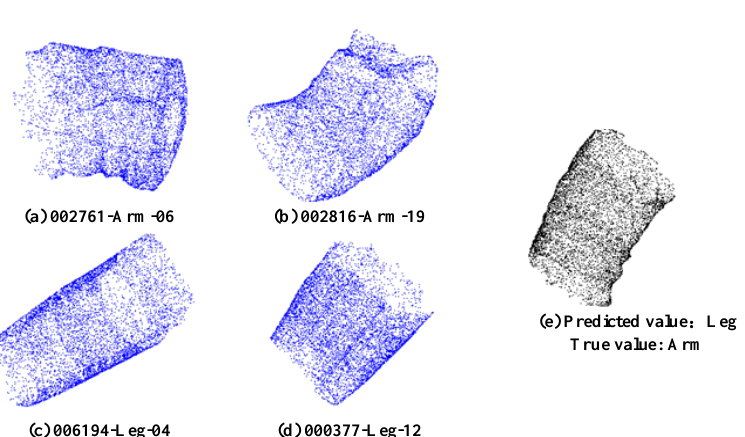
Figure 14. Some fragments of class Arm ( a , b ) and Leg ( c , d ). ( e ) Misclassification result.